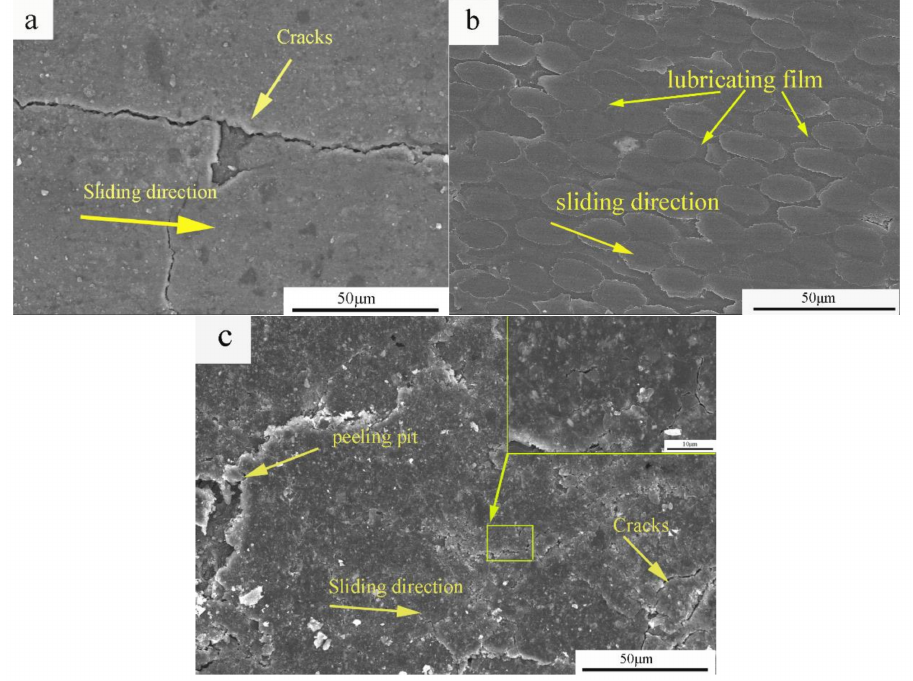
Figure 7. SEM micrographs of the worn surface on composites with the corresponding components. ( a ) Pure carbon slide; ( b ) C/C; and ( c )